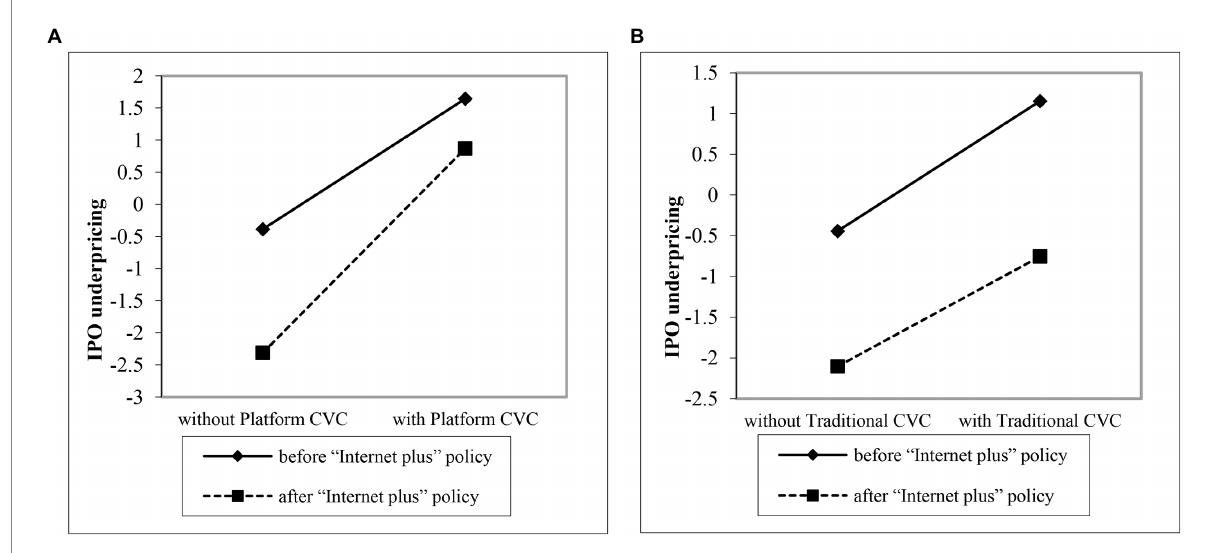
FIGURE 3 the moderating effect of “Internet plus” policy. (A) Platform CVC. (B) Traditional